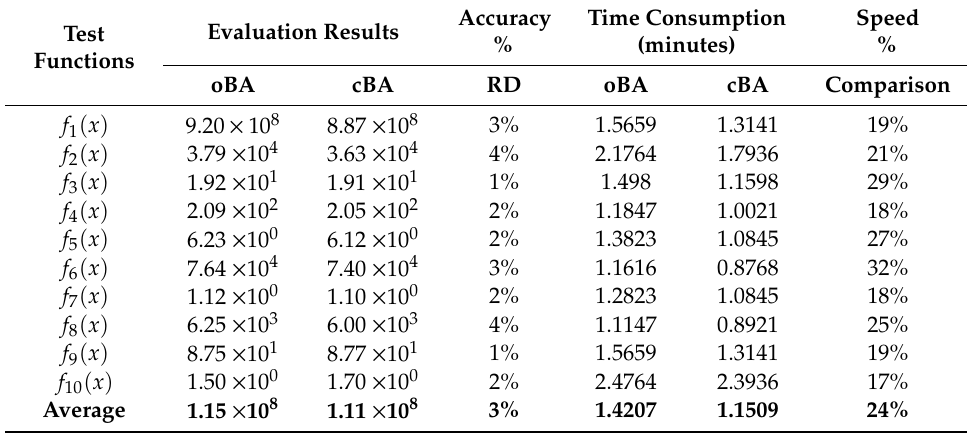
Table 2. Comparison evaluation and speed of the cBA and oBA regarding the quality performance.